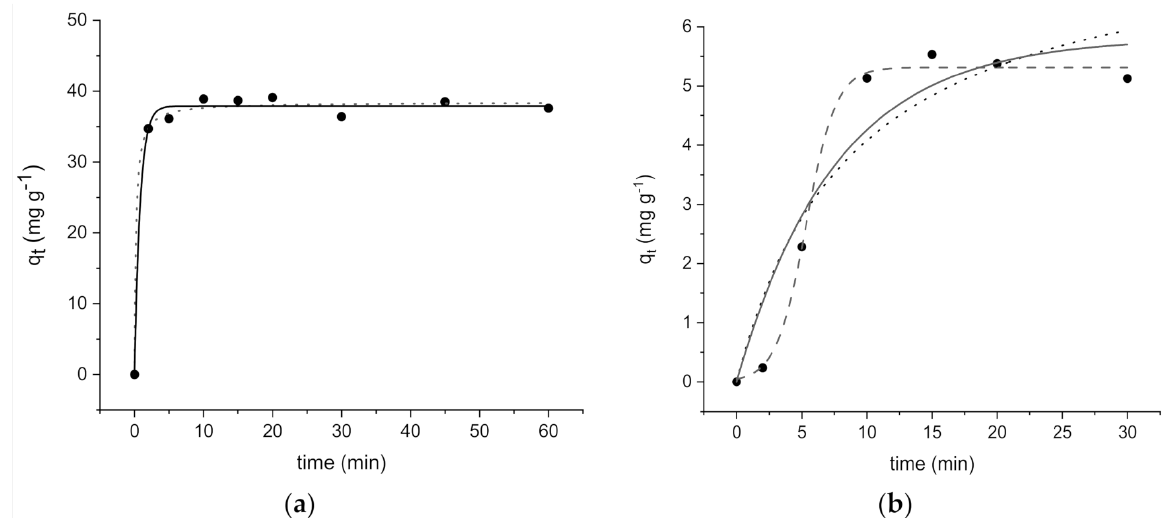
Figure 5. Kinetic profiles (pseudo-first-order ( ), pseudo-second order ( ), and sigmoidal ( )) for Ofloxacin (OFL) on ( a ) ZIF-8 (Experimental conditions: metal-organic frameworks (MOF) 20 mg, 40 mL tap water, OFL initial concentration 36 mg L − 1 ) and ( b ) Zn 3 (BTC) 2 (Experimental conditions: MOF 20 mg, 40 mL tap water, OFL initial concentration 12 mg L − 1